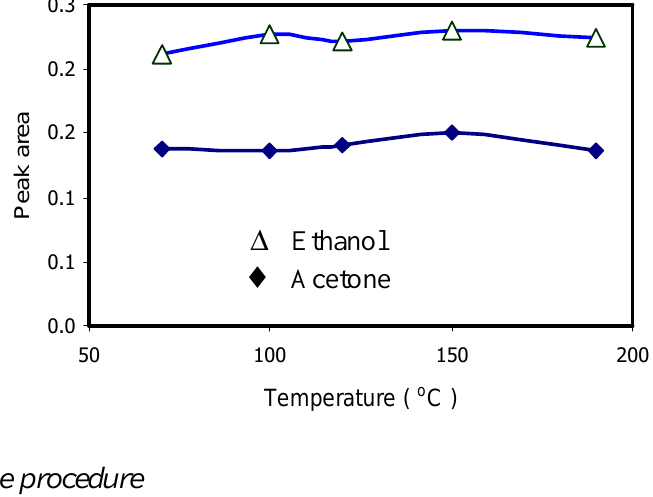
Figure 6. Relationship between peak areas of ethanol and acetone and the injection port